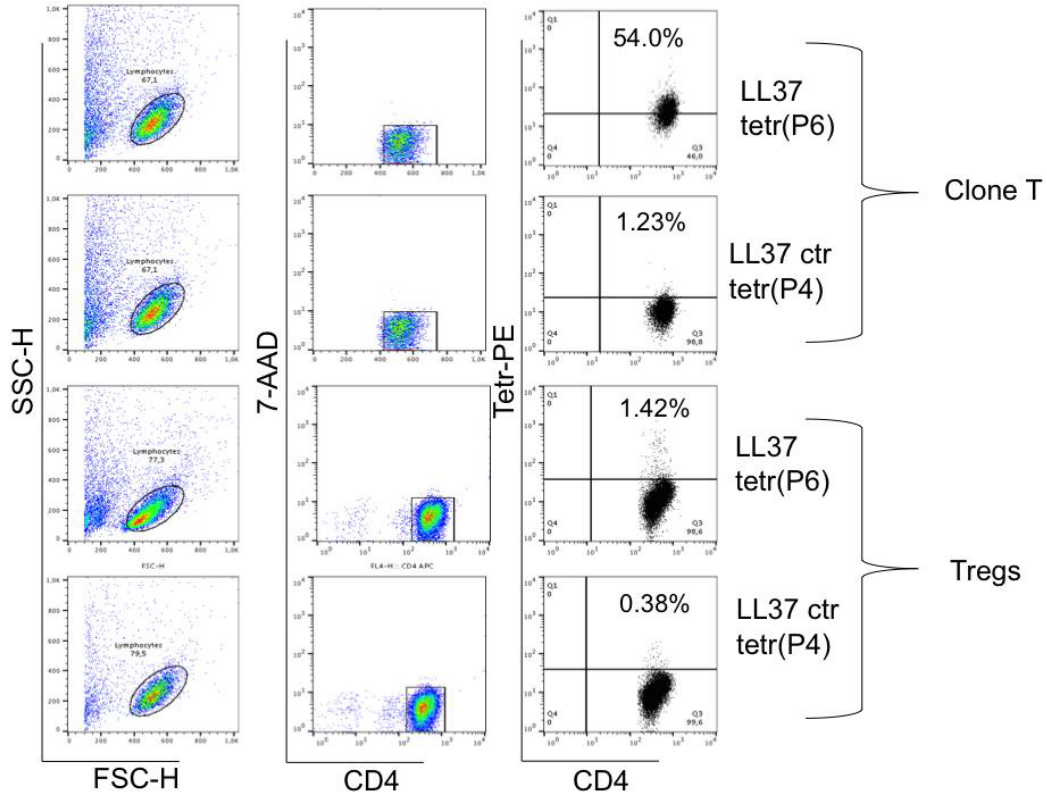
Figure 1. Enriched Tregs isolated from PBMCs are LL37-specific. Clone T, specific for LL37 P6 was stained with peptide-MHC-tetramer DR11-P6 (see methods), upper panels, and peptide-MHC-tetramer P4 (control tetramer, ctr). Tregs were isolated from PBMCs from the same HD and cultured for 3 weeks in the presence of 300 U/mL of hrIL-2. These cells were stained with the same peptide-MHC-tetramer and control peptide-MHC-tetramer as for the clone, lower panel. Experiments were repeated three times, with the same donor.